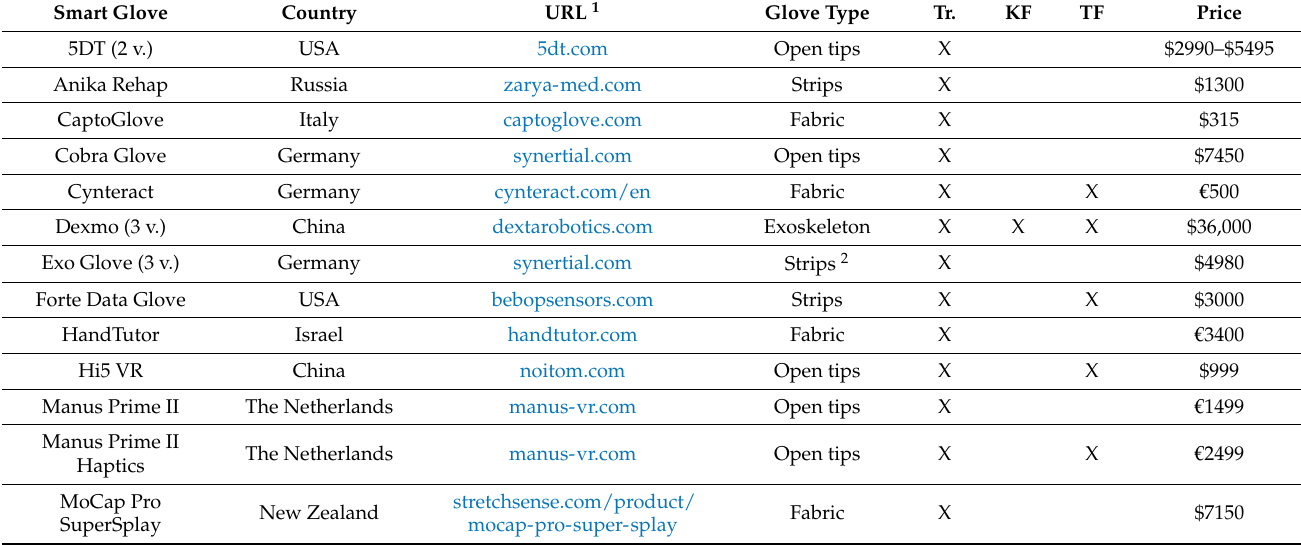
Table 2. Commercial smart gloves (first row abbreviations: Tr. = “Hand and finger pose estimation and motion tracking”; KF = “Kinesthetic Feedback”; TF = ”Tactile Feedback”; first column abbreviations: v. =